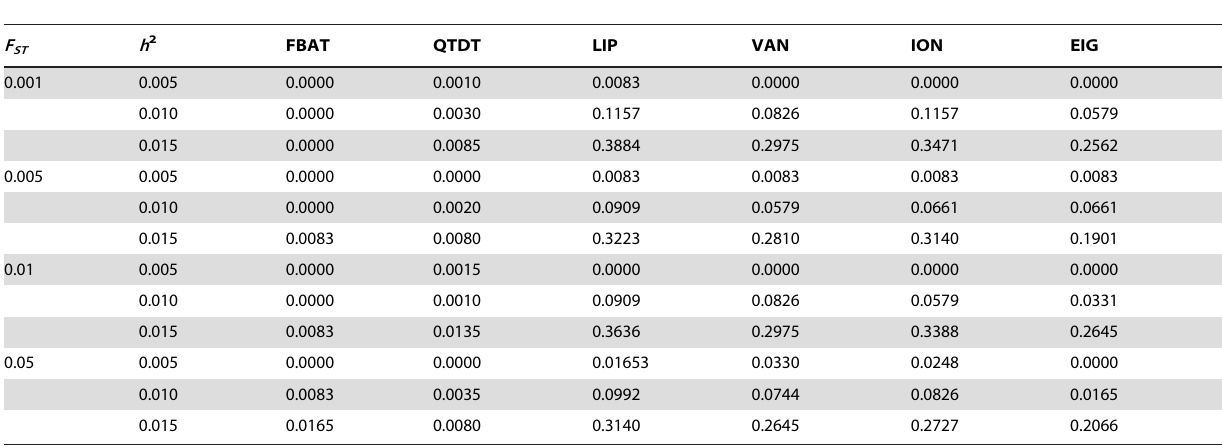
Table 5. Empirical power for GWAS under population